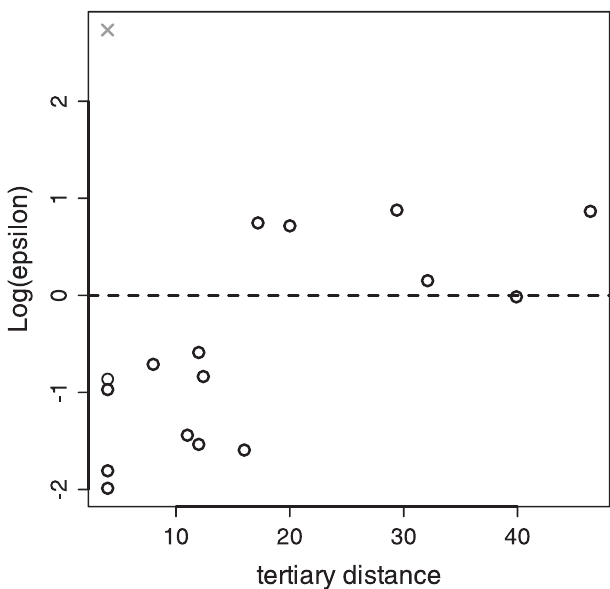
Figure 1. The Nature of Glycan Interactions Depends on Their Intramolecular Distance Potential PNGSs that were identified by the disequon model as having significant interactions with other PNGSs were mapped to a structural model of HIV-1 gp120. Intramolecular distances between interacting PNGSs were measured using the visualization software UCSF Chimera [53]. When an asparagine residue corresponding to a PNGS was not present in the structural model, the distance between pairs was approximated by 4.0 A˚ times the number of residues separating the PNGSs, to a maximum of five residues. If the number of residues exceeded five, then the unmapped pair was omitted from the analysis.